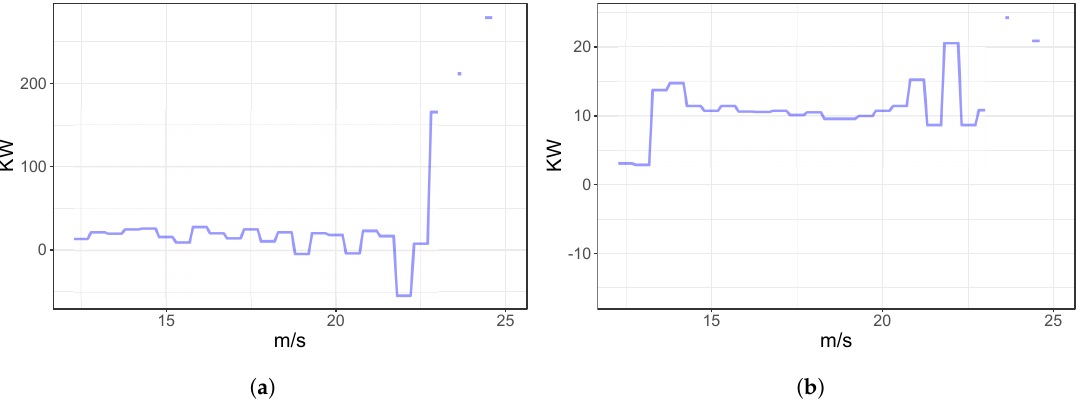
Figure 2. Curve of the difference of the generated power after maintenance minus before maintenance. Horizontal axis is the wind speed in m/s, vertical axis is the energy production in KW. Panel ( a ) is calculated by subtracting the mean values, while panel ( b ) is calculated by subtracting he median